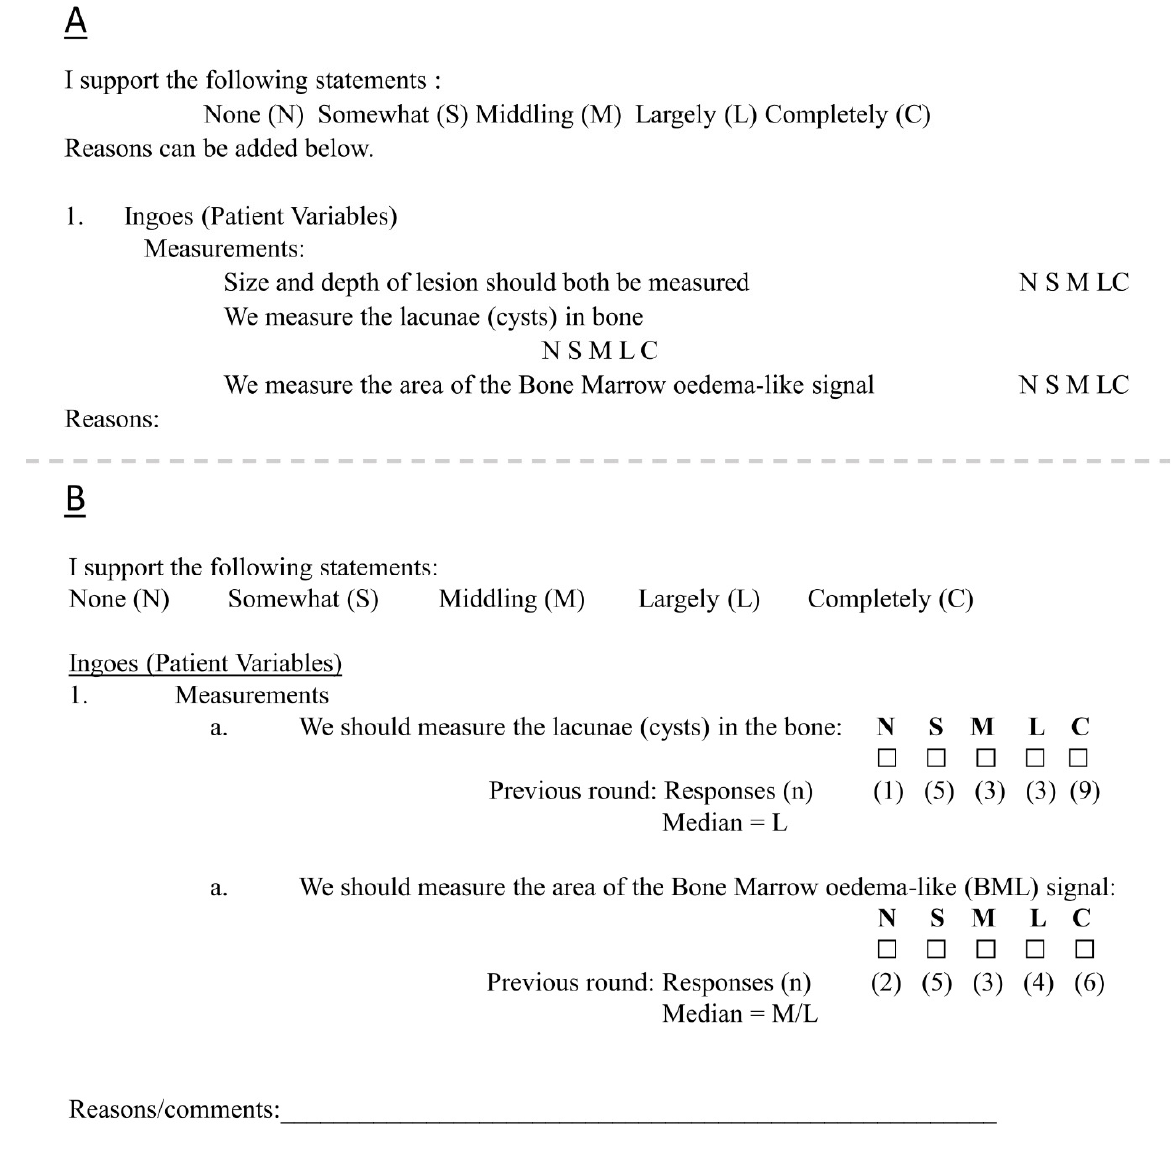
Figure 2. ( A ) Example of Likert-rated, single-statement question layout from the round 2 questionnaire, including the 5-point Likert scale. ( B ) Example of Likert-rated, single-statement question layout from the round 3 questionnaire, including the 5-point Likert scale. In the round 3 questionnaire, the DELPHI panel was also provided with a summary of the group answers (a count of answers and the median) and directly quoted comments from the previous round. Note that the first statement ‘size and depth of lesion should both be measured’ is no longer present on the round 3 questionnaire, as this statement reached the threshold consensus levels in round 2 and was removed from the subsequent questionnaire.